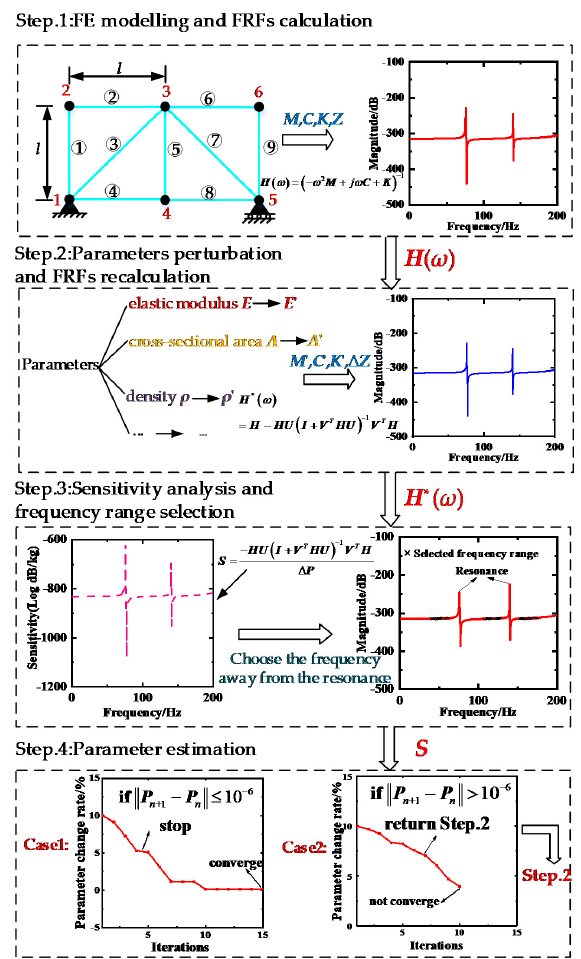
Figure 2. Model updating implementation steps.